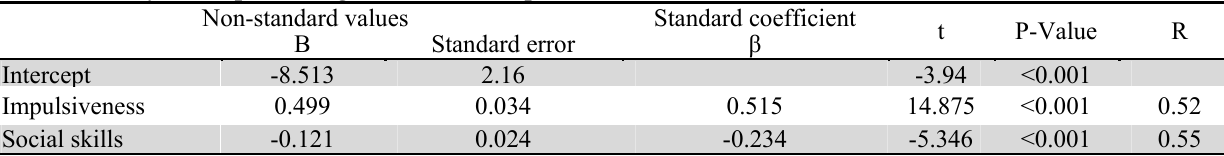
The summary of stepwise regression